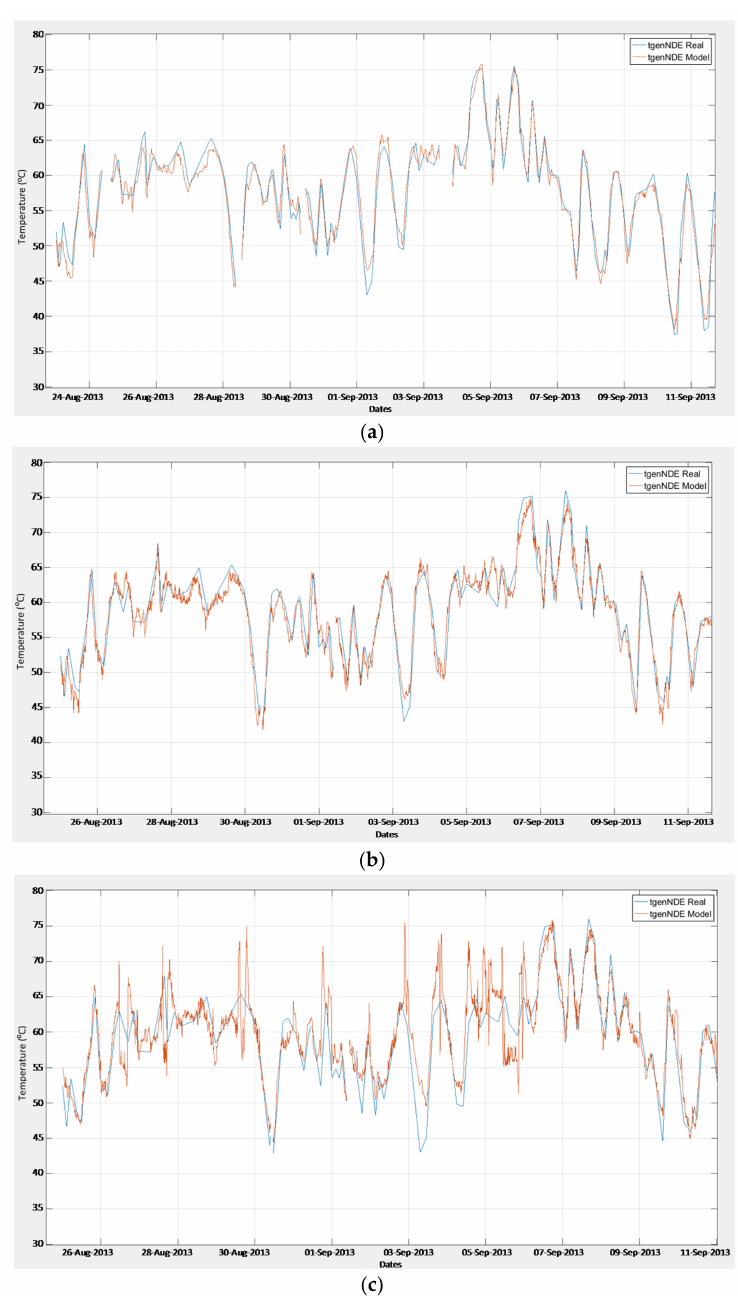
Figure 10. Real temperature (in blue) and estimated temperature (in red) of the NDE bearing for: ( a ) Specific Model, ( b ) Generic Model, and ( c ) Specific Model After